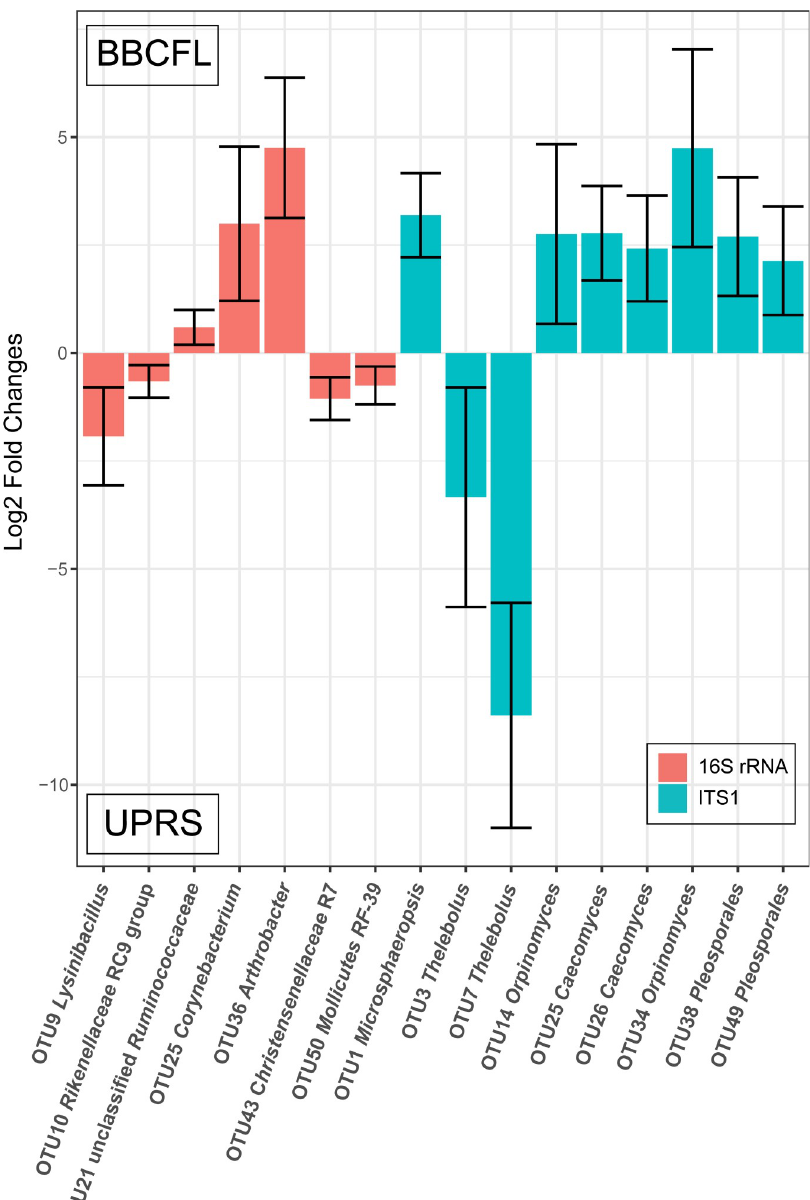
Fig 2. Statistically significantly ( q � 0 . 05 )different abundant bacterial and fungal OTUs considering location (BBCFL, UPRS) as an effect. The differences in abundance of OTUs are shown as log2 fold changes for each location. Positive values represent higher abundance in farm BBCFL, negative values represent higher abundance in farm UPRS. Error bars represent the 95% confidence interval.